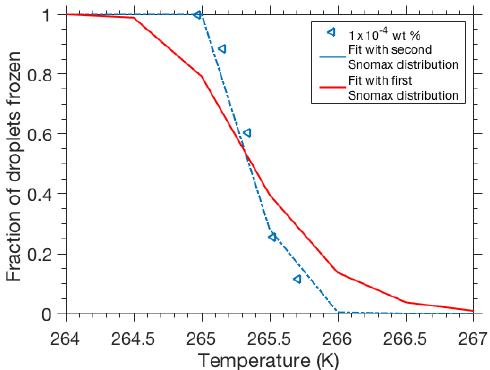
Figure 4. The 1 10 − 4 wt% Snomax frozen fraction curve (sym- × bols), corresponding to the highest concentration freezing spectrum where freezing was exclusively determined by the g 2 distribution of HIN activity. Freezing spectra fits are also included, one derived using the g 2 distribution of HIN activity (dashed line), while the other is a hypothetical fit corresponding to the activity of the g 1 distribution (solid